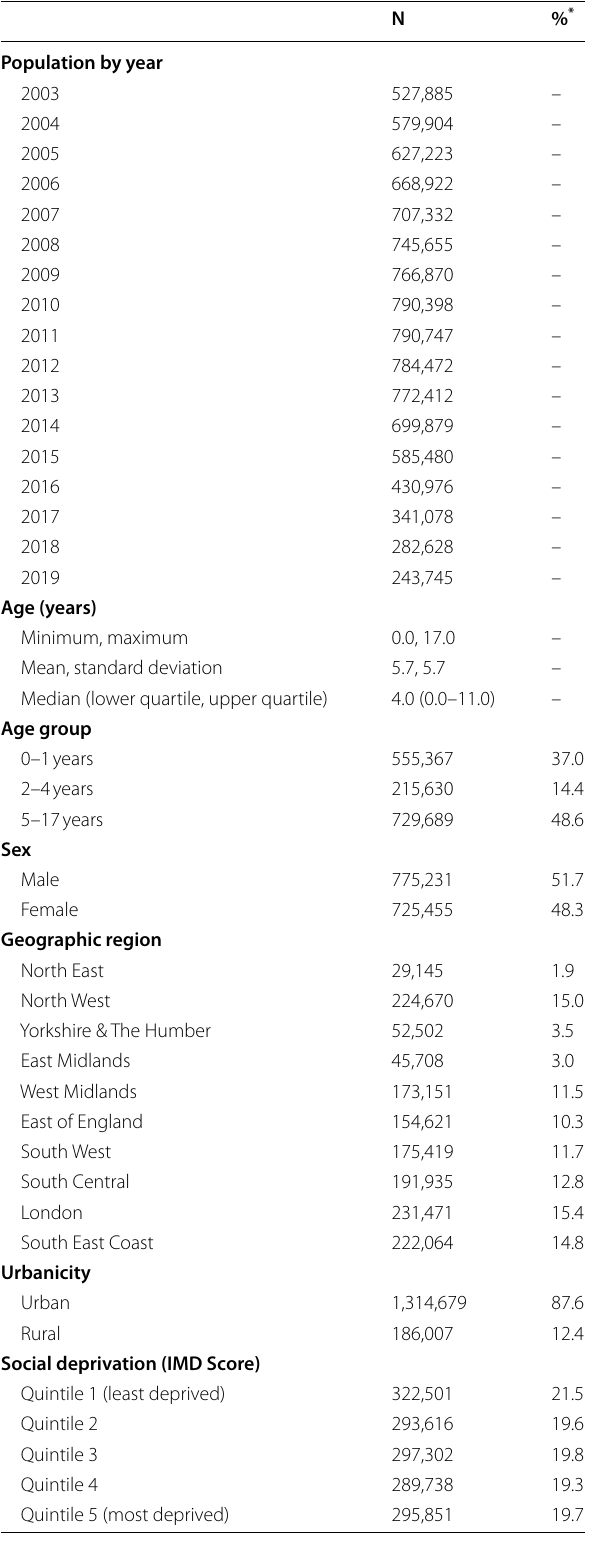
Table 1 Baseline characteristics of the study